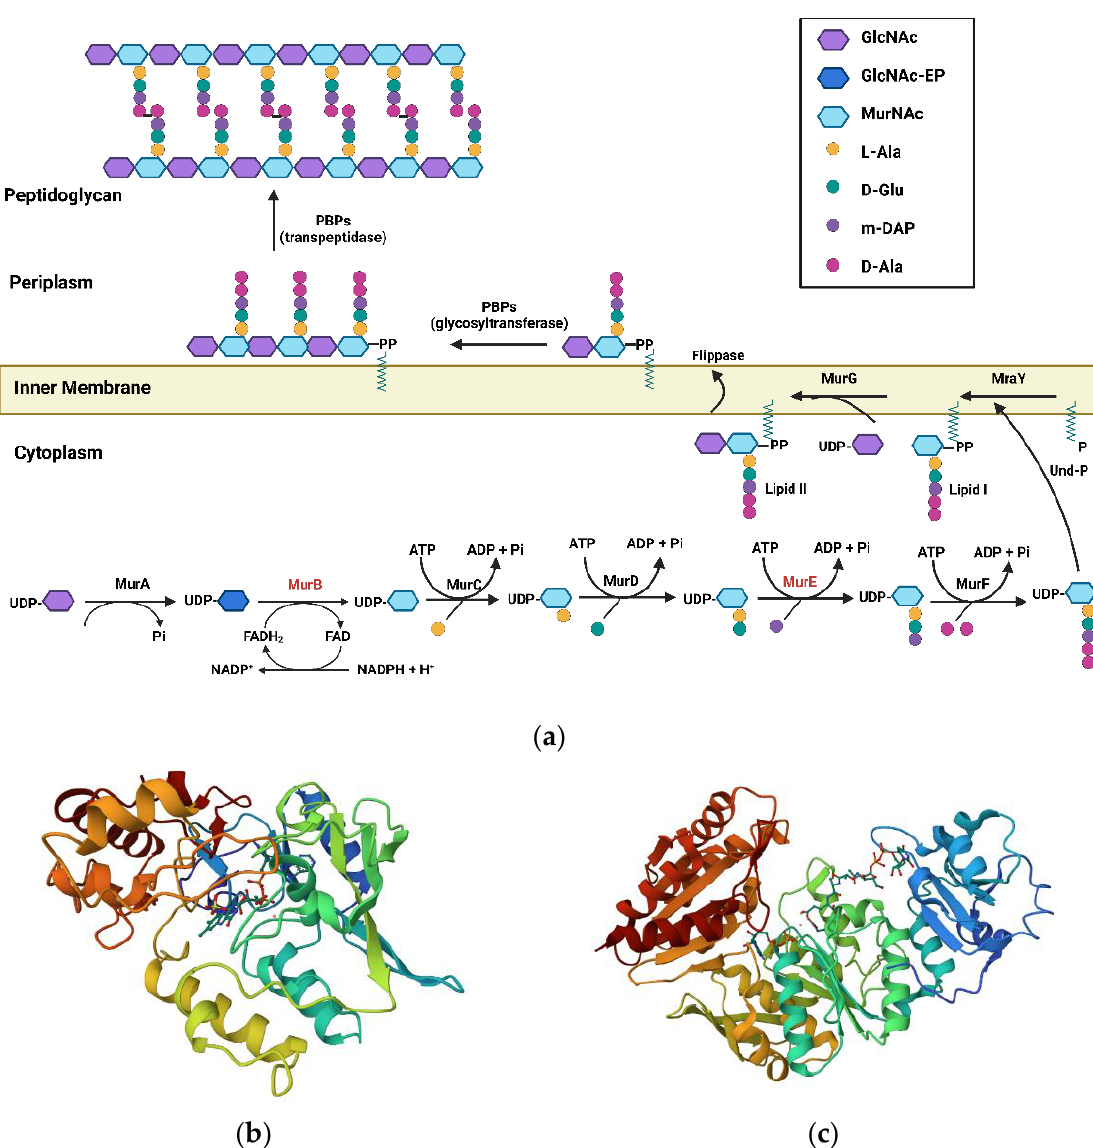
Figure 1. ( a ) Peptidoglycan biosynthesis pathway depicting various Mur enzyme families. ( b ) Crystal structure of E. Coli Mur B (1MBT) [25]. ( c ) Crystal structure of Mtb Mur E (2XJA) [27].